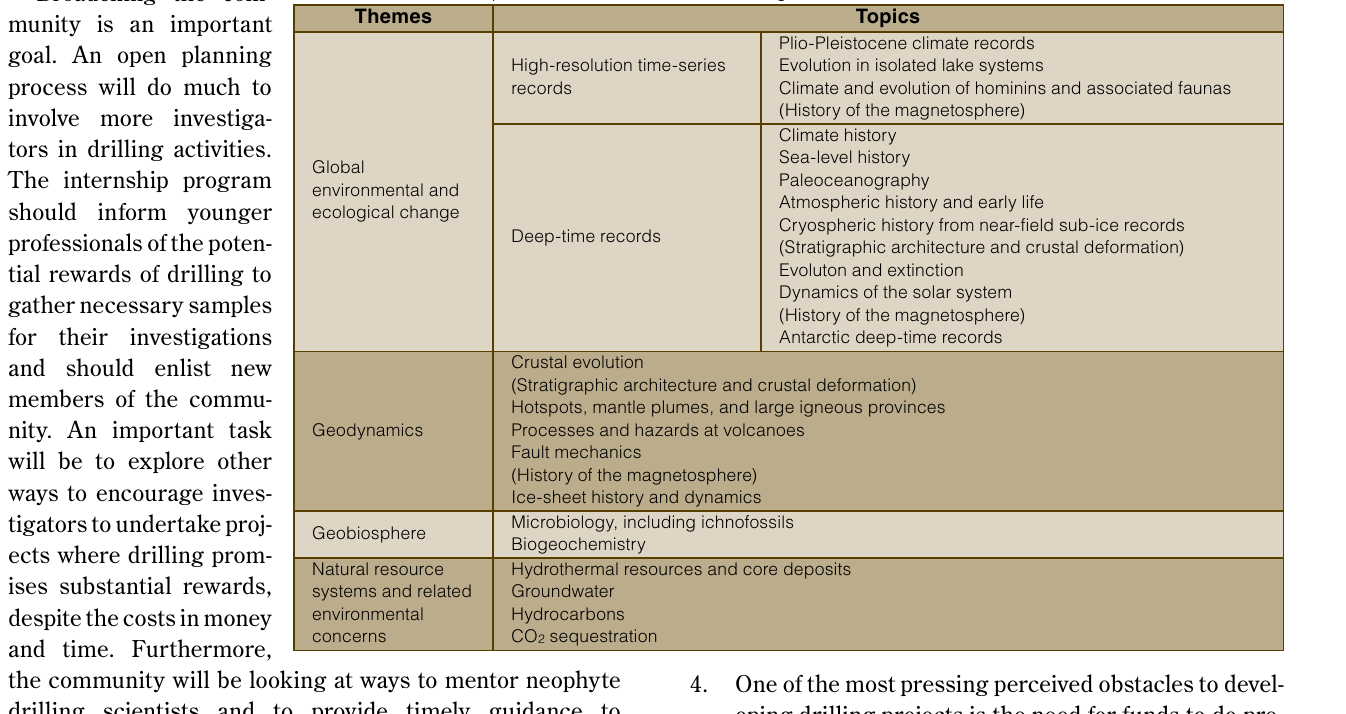
Table 1. Themes and topics in continental scientific